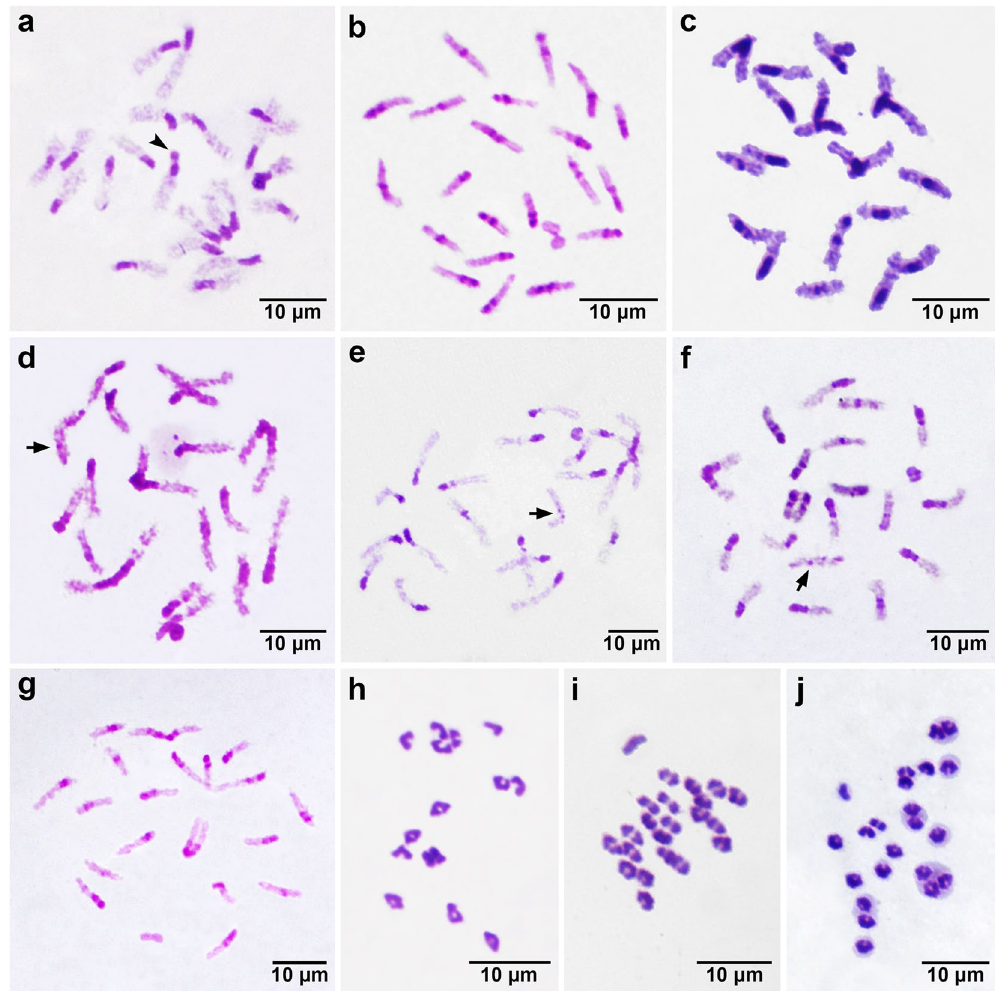
protrudens ; ( f ) C . nanwutaina ; ( g ) C . sinuata . Arrows point to the heteromorphic bivalent; arrowhead points to the satellite